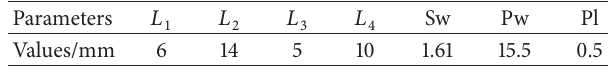
Table 1: Dimensions of the proposed